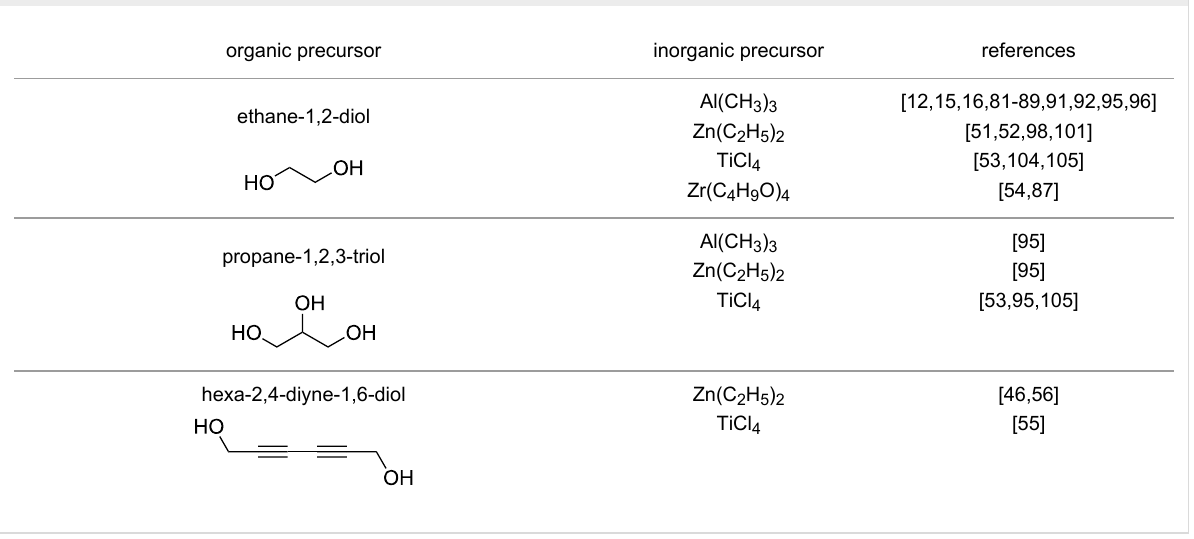
Table 11: Alcohol and phenol precursors used to deposit inorganic–organic hybrid thin